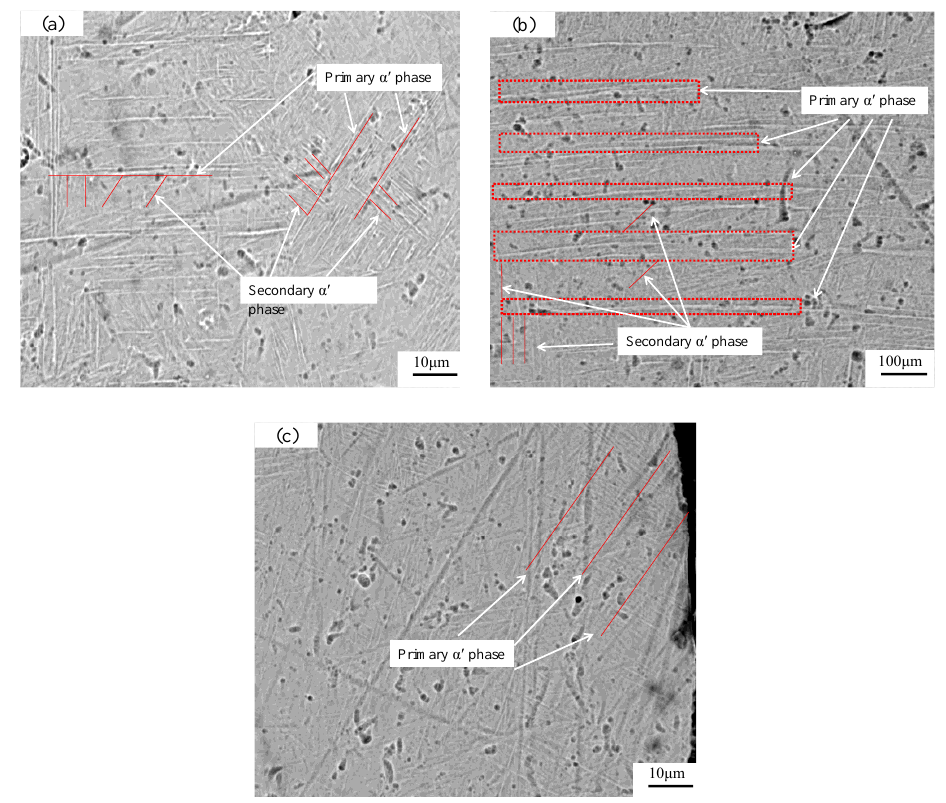
Figure 13. SEM image analysis. ( a ) 2#; ( b ) The center of specimen 9#; ( c ) The edge of specimen 9#. Through the analysis of the microstructure, the internal mechanism of the specimen formed by the VPFP was further revealed. The content of the secondary martensite α’ phase of the specimen formed by the VPFP decreased. The length of the primary α’ phase became shorter, the width increased with the superposition of hierarchies, and the width of the columnar crystal β phase became smaller than that of the columnar crystal β phase formed by the QPFP. 4. Conclusions In this study, the tensile specimens with aerosolized TC4 titanium alloy powder were formed by SLM, using two different forming processes (the variable parameter forming